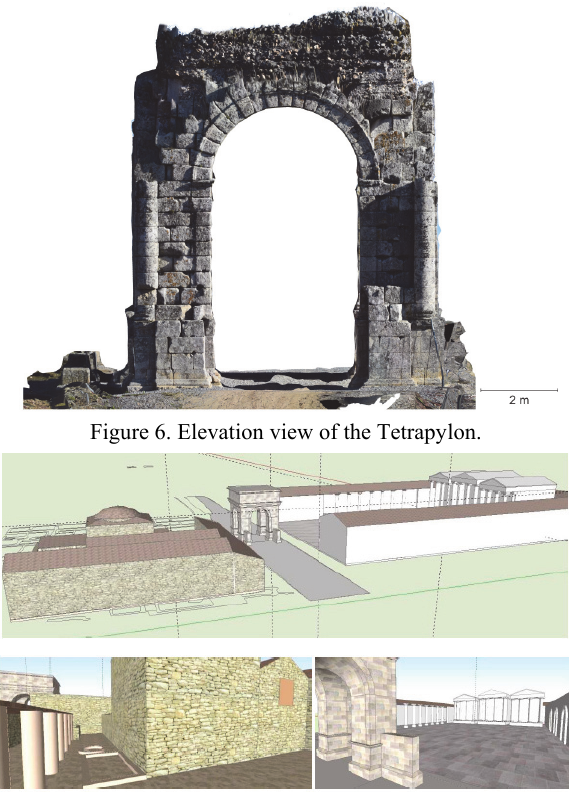
Figure 7. Final results of the virtual anastylosis.